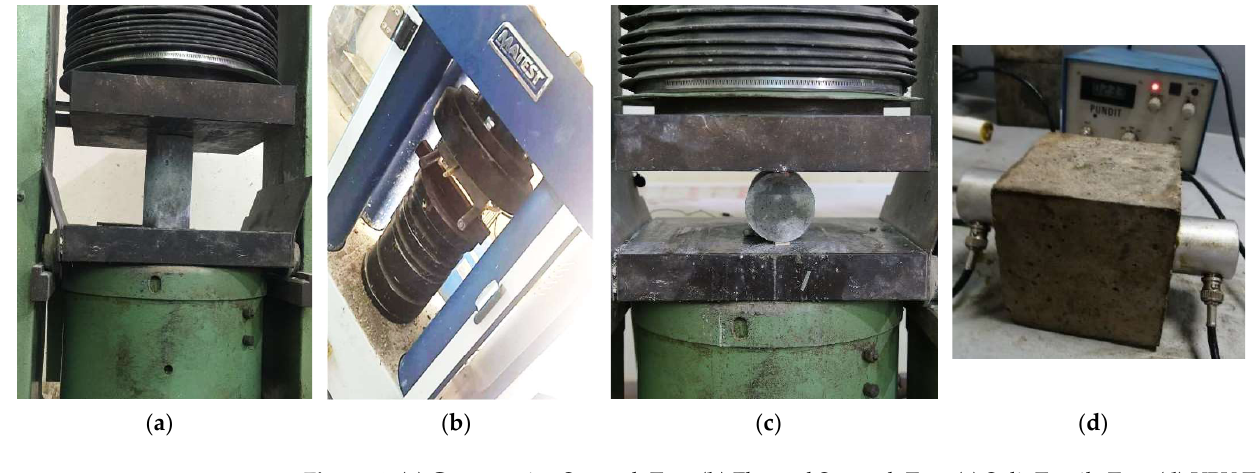
Figure 4. ( a ) Compressive Strength Test; ( b ) Flexural Strength Test; ( c ) Split Tensile Test; ( d ) UPV Test.